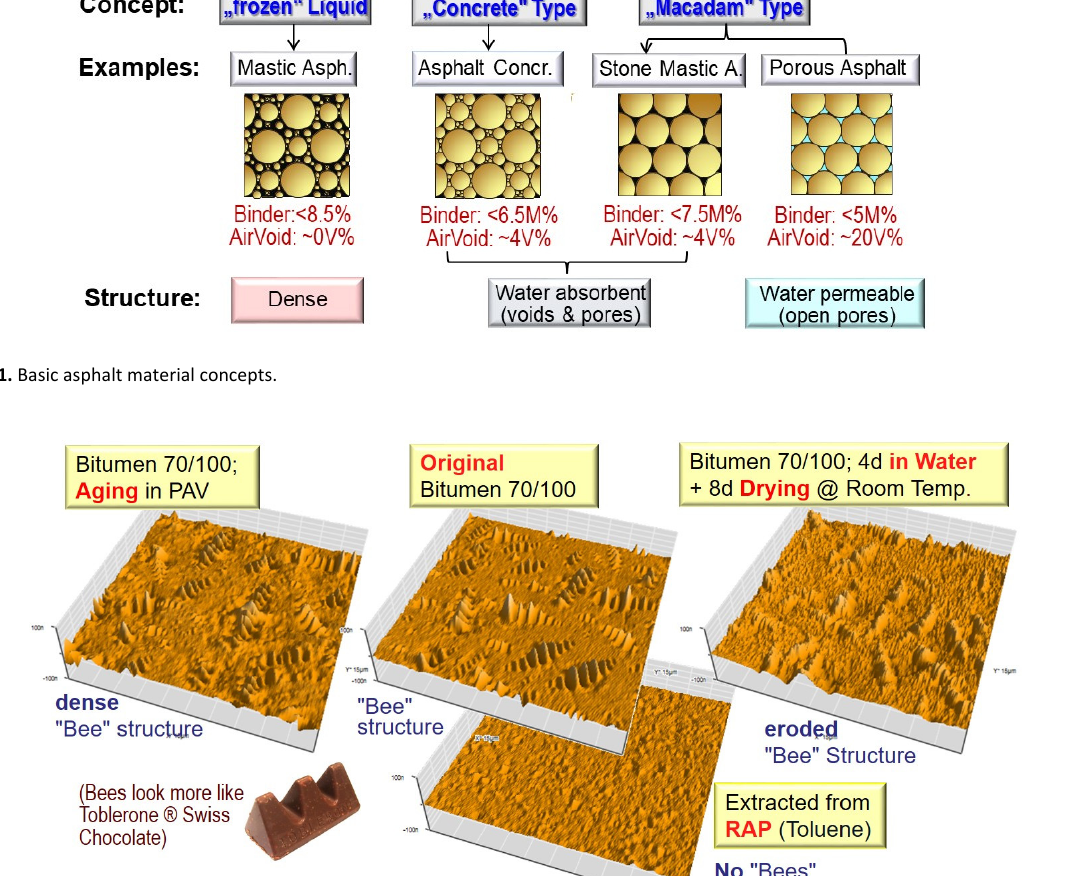
Figure 2. AFM Bitumen topography, after 20min annealing at 110 °C and (if not water conditioned) left at room temperature 24h before AFM; 15µm 2 are